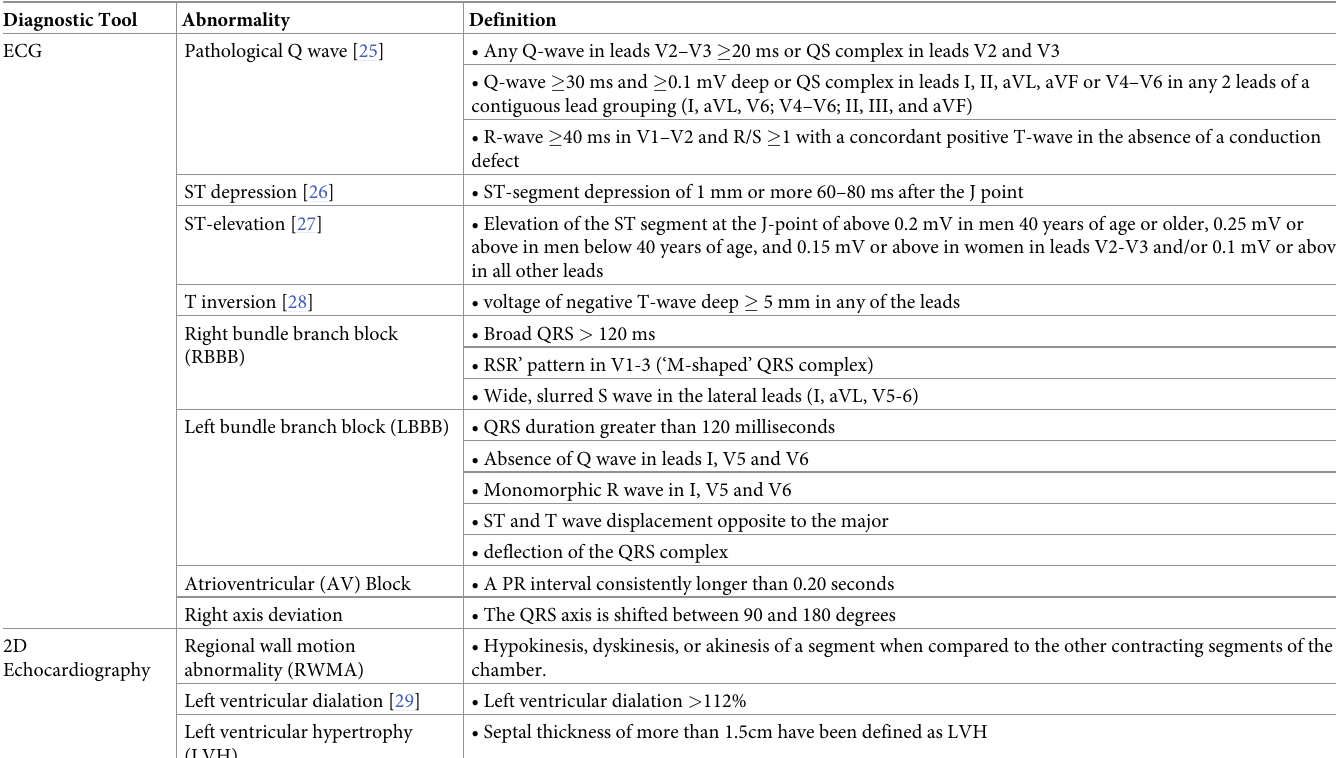
Table 1. Assessed abnormalities by ECG and